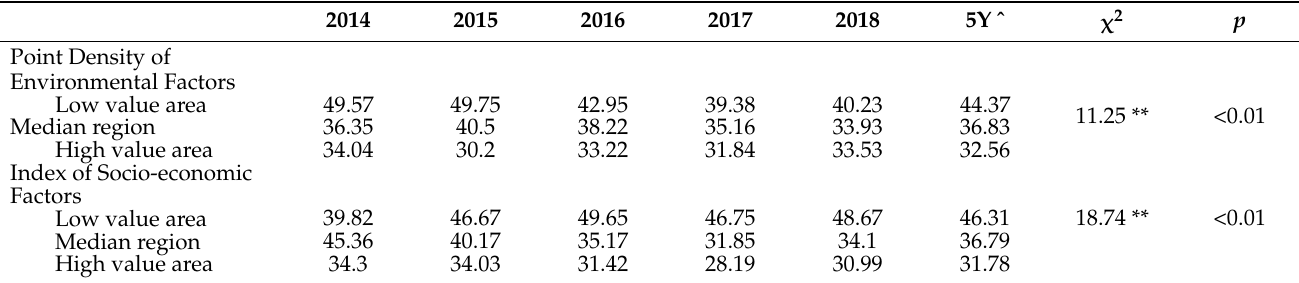
Table 4. GMR in different groups of counties in the HRB classified by the point density of environ- mental factors and index of socioeconomic factors from 2014 to